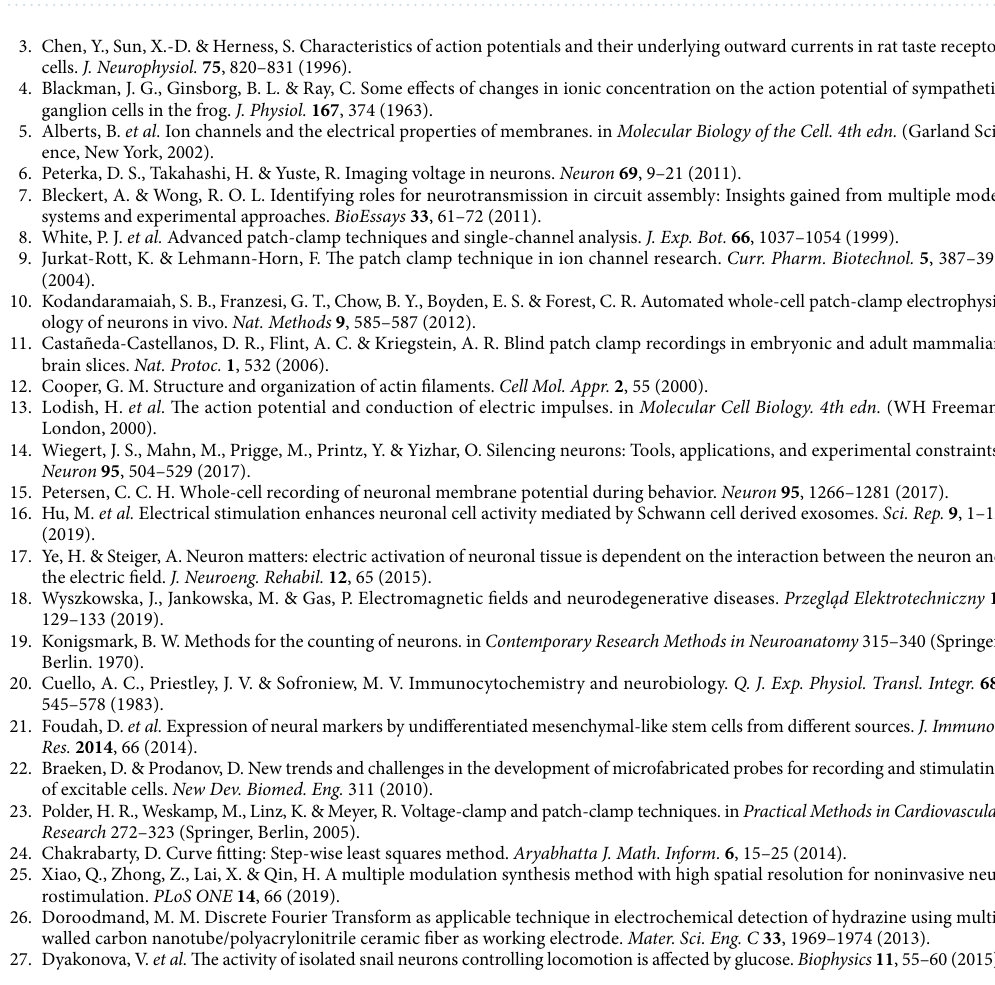
Figure 11. Modeling of quadrupole well potential V 0 (x) inside the neuron recycling network. W 1–4 revealed to the weight of each current